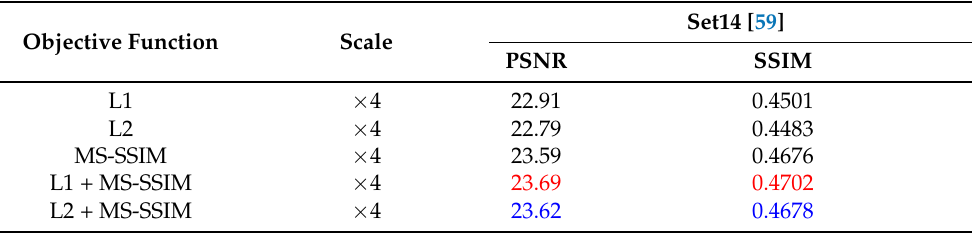
Table 11. Quantitative evaluation of different objective functions with noise degradation (kernel with = 0.5 and noise level = 15) for the Set14 dataset at × 4 scale.